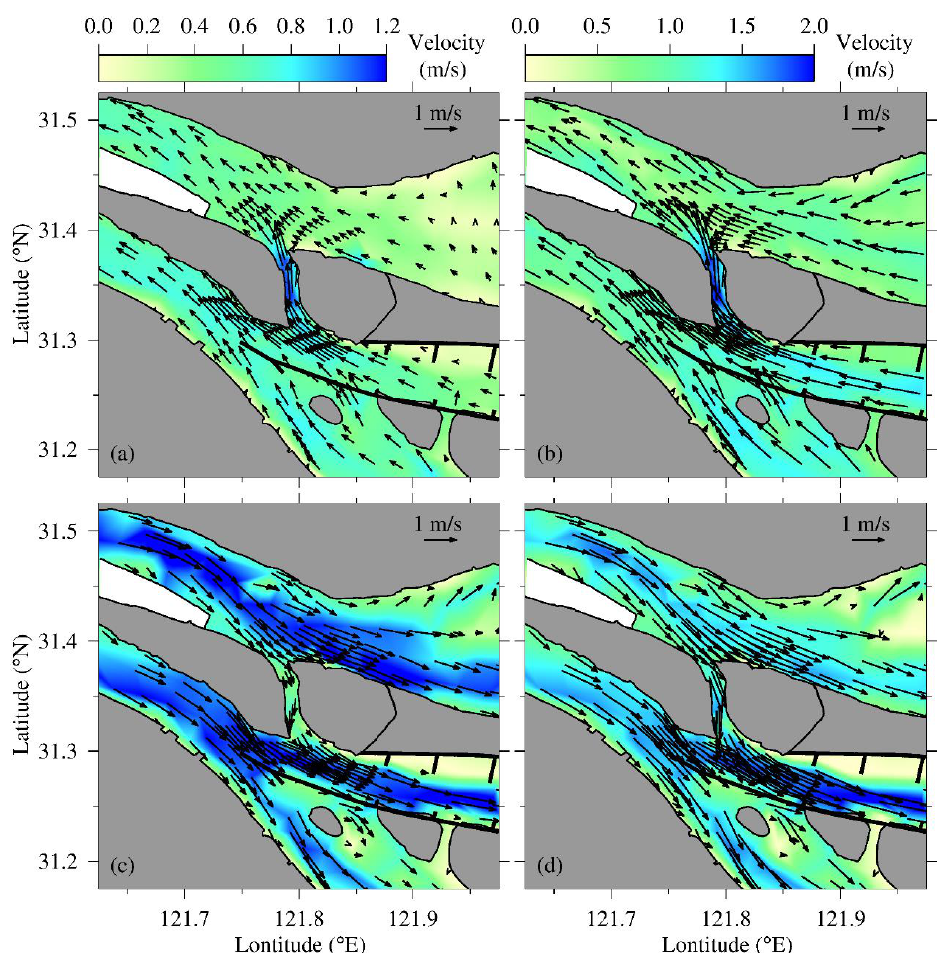
Figure 8. Modeled surface currents around the HC at the maximum flood ( a , b ) and maximum ebb ( c , d ) during the neap tide (left panels) and the spring tide (right panels) in EX0. During flood tide, water entered the NC through the HC, where the flow direction was reversed during ebb tide. The water flux across the section could reflect the mean current velocity, and its peaks corresponded to the maximum flood current and maximum ebb currents. During the neap tide, the time of the maximum water flux in the HC was later than that across the sections in the NC and NP (Figure 9a); during the spring tide, the time was earlier than that across the sections in the NC and NP (Figure 9b).